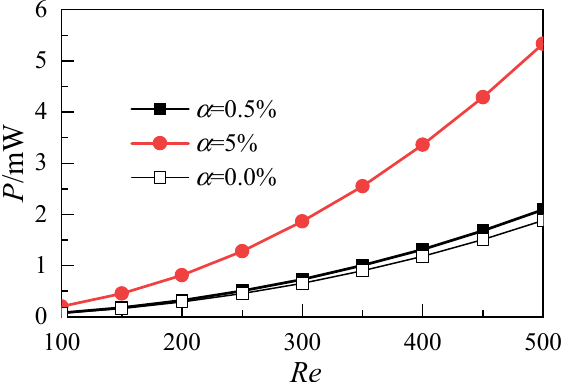
Figure 8. Effect of nanoparticle volume fraction on inlet velocity.